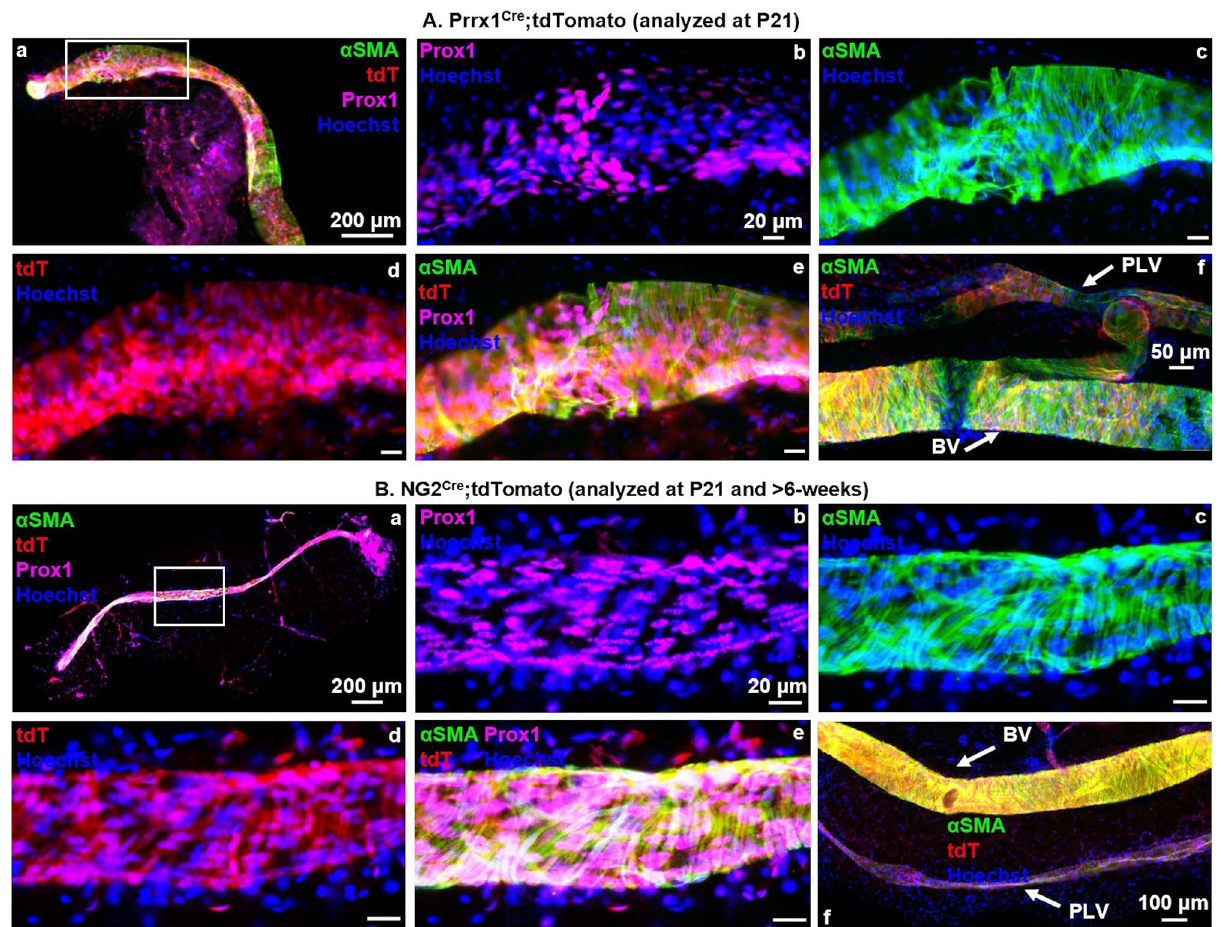
Figure 3. PLV-LMCs originate from a Prrx1 + and NG2 + progenitor cell similar to VSMCs prior to P21. Multicolor fluorescent microscopy was performed on whole mount immunostained PLVs and adjacent blood vessels (BVs) from constitutive Prrx1 Cre (n = 3, P21 depicted) and NG2 Cre (n = 4, P90 depicted) reporter mice as described in Fig. 1. Representative low-magnification overlay images of all channels show the PLVs with a highlighted region of interest (white boxes) ( A.a , B.a ). High-magnification images of the region of interest show Prox1 immunostain of LECs ( A.b , B.b ), αSMA immunostain of LMCs ( A.c , B.c ), Cre-driven tdT expression ( A.d,B.d ), overlay of all channels ( A.e , B.e ), and positive control BV VSMCs directly adjacent to PLVs ( A.f , B.f ). Note tdT expression (red) in PLVs ( A.d , B.d ) that colocalizes with αSMA + LMCs ( A.e , B.e ), which is more profound (yellow) on the VSMC dense BVs, as expected ( A.f , B.f While the differential expression of NG2 during PLV-LMC development indicates that PLV-LMC progeni- tors derive from two distinct sources, the ubiquitous expression of tdT in PLV-LMCs of NG2 Cre animals at both